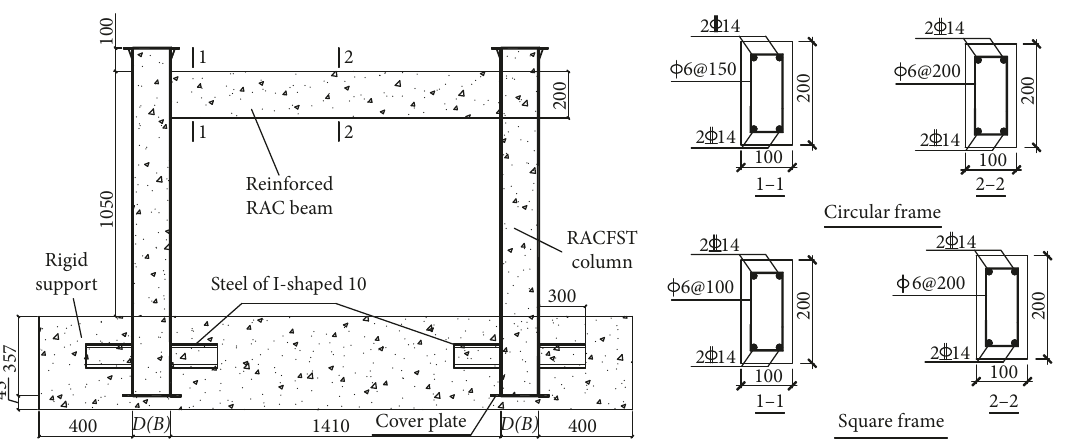
Figure 1: Elevation of the specimens. Table 1: Specific design parameters of the specimens.